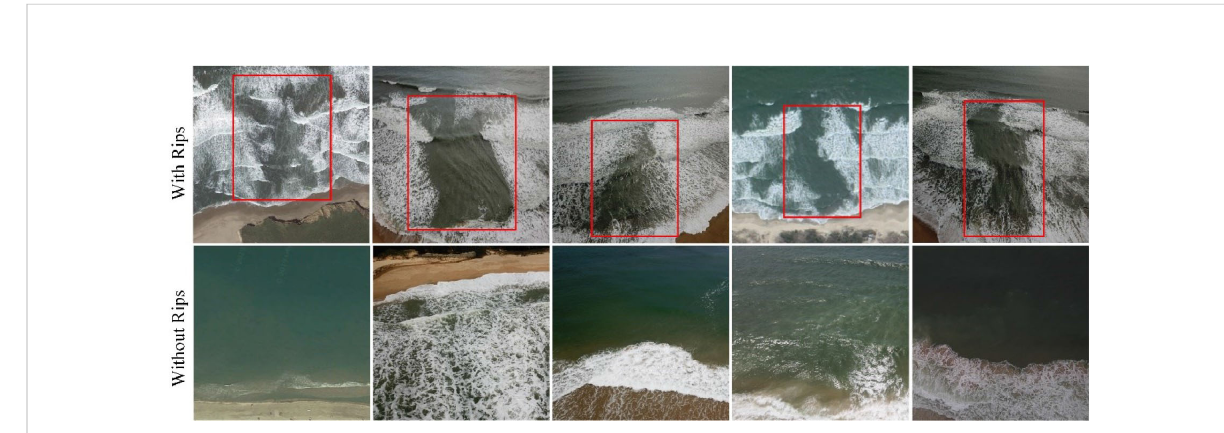
FIGURE 5 A set of images in the training set. The upper part of the images all contained rip currents, and red boxes indicate the boundaries of the rips. The lower part of the images did not contain rips.